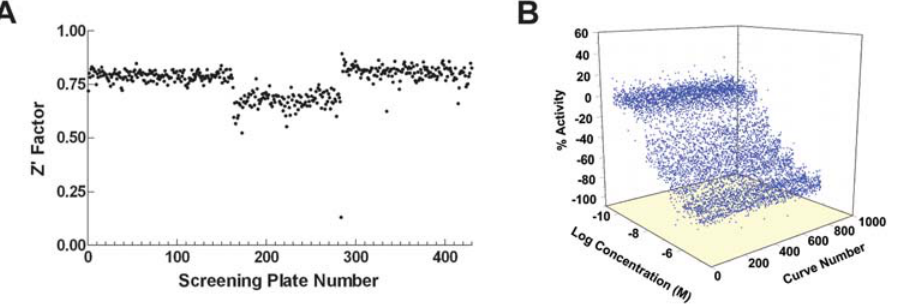
Figure 3. qHTS performance. Z 9 trend (A) and intraplate control titrations (duplicate curves per plate) (B) as a function of plate number.